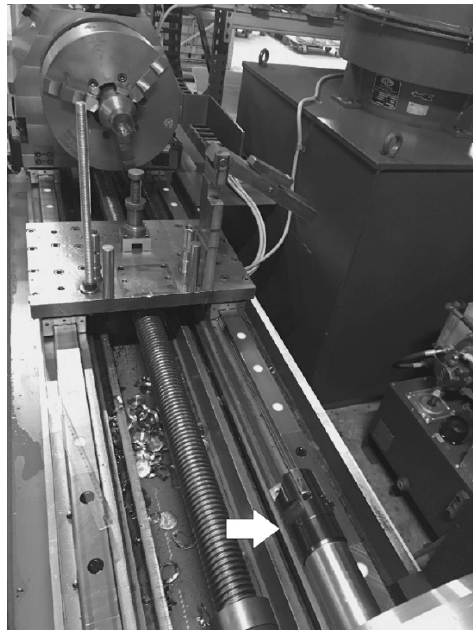
Figure 2. The view of the fragment of the TUC 40 lathe system used in the tests. The lying drill head is marked by the arrow.